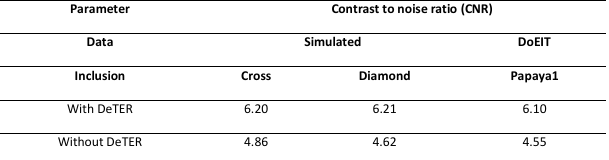
Table 3: Improvement in CNR